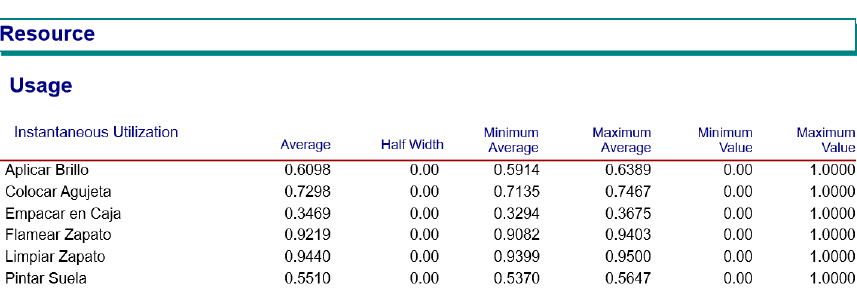
Figure A4 . Utilization per activity. Proposal